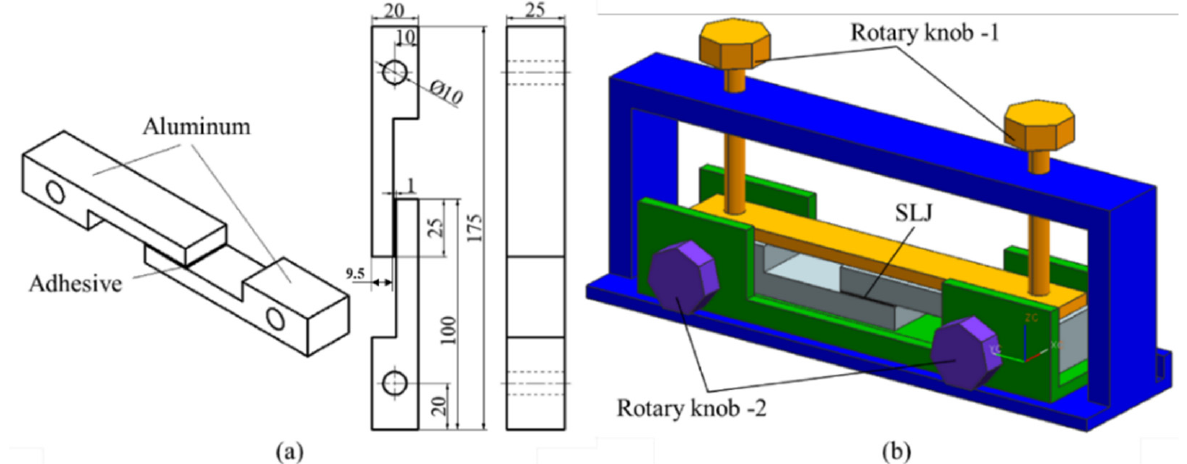
Figure 1. ( a ) Geometric dimension of the joint (unit: mm), ( b ) Schematic diagrams of the fixture.